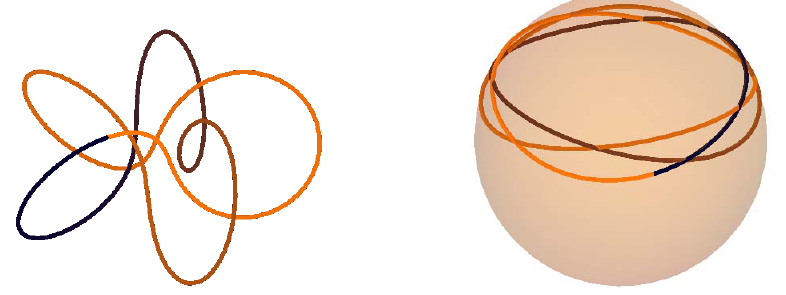
Figure 1. On the left, an example Wilson loop that lies in a great S 3 S 5 , plotted after K ⊂ performing a stereographic projection from S 3 to R 3 . On the right, we plot the shape of the loop in the internal S 2 S 4 . We interpolate in coloring from light to dark as we go around the loop in ⊂ both figures. The colors are coordinated between the two